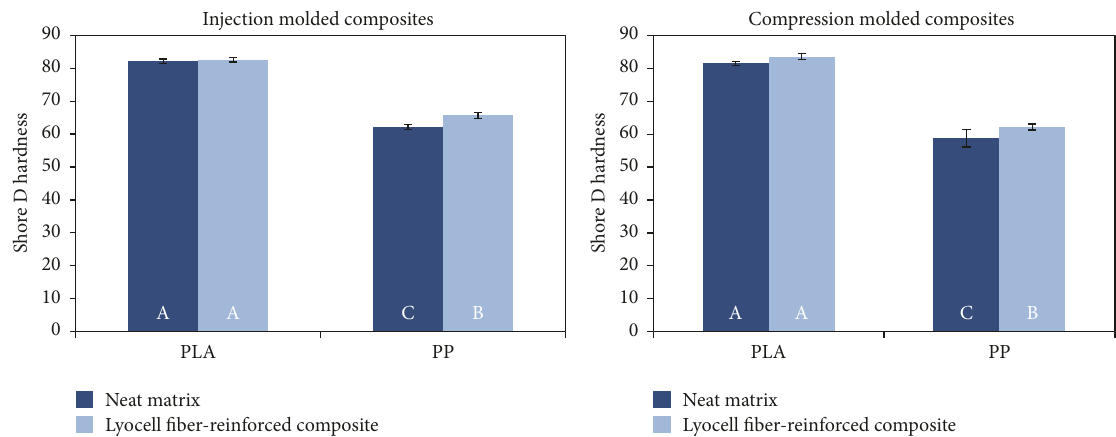
Figure 1: Shore D hardness of neat IM and CM matrices and lyocell fiber-reinforced composites (mean value ± standard deviation; different letters show significant differences). Table 1: Tensile characteristics of PLA, PP, and their composites (mean value ± standard deviation). Material Tensile strength in MPa Young’s modulus in GPa Elongation at break in